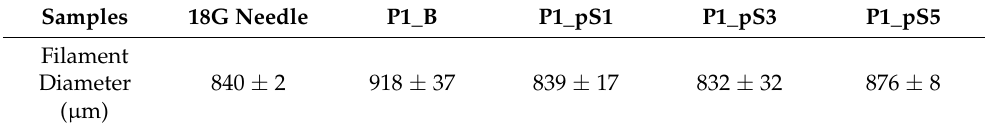
Table 3. Average filament diameter for each of the four different 3D printed scaffold compositions.